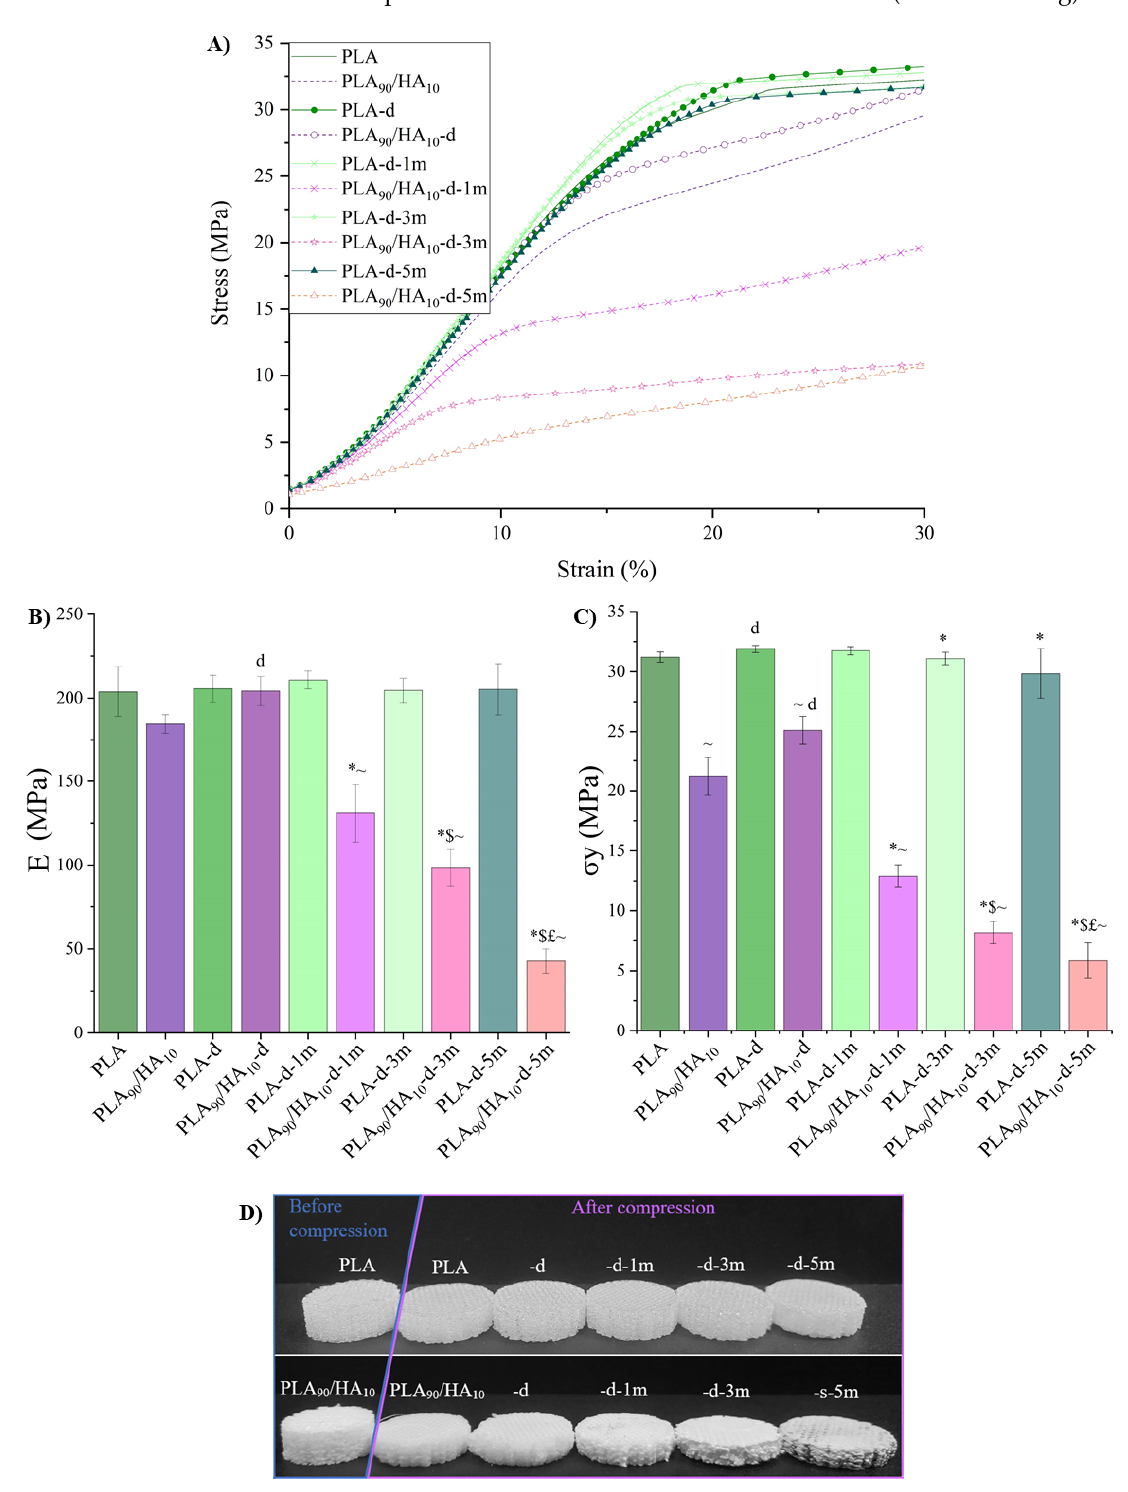
Figure 12 . Mechanical properties in compression at yield: ( A ) Compression curves; ( B ) compression modulus; ( C ) compression strength at yield (or flexure point); ( D ) aspect of the scaffolds before/after compression. Mann–Whitney test p < 0.05; significant effect of decontamination (d); for PLA or PLA 90 /HA 10 : * vs. -d, $ vs. − 1 m, £ vs. − 3 m; for PLA 90 /HA 10 : ~ vs. PLA (of the same condition). For the non-degraded PLA and PLA 90 /HA 10 , the elastic moduli are comparable (204 MPa for PLA and 185 MPa for PLA 90 /HA 10 ), but the compressive strength of PLA 90 /HA 10 decreased with the addition of HA (21.2 MPa for PLA 90 /HA 10 against 31.2 MPa for PLA).